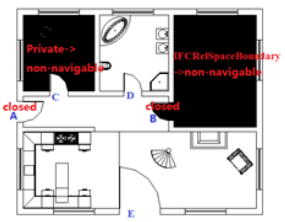
Figure 4. Single floor semantic information extraction in